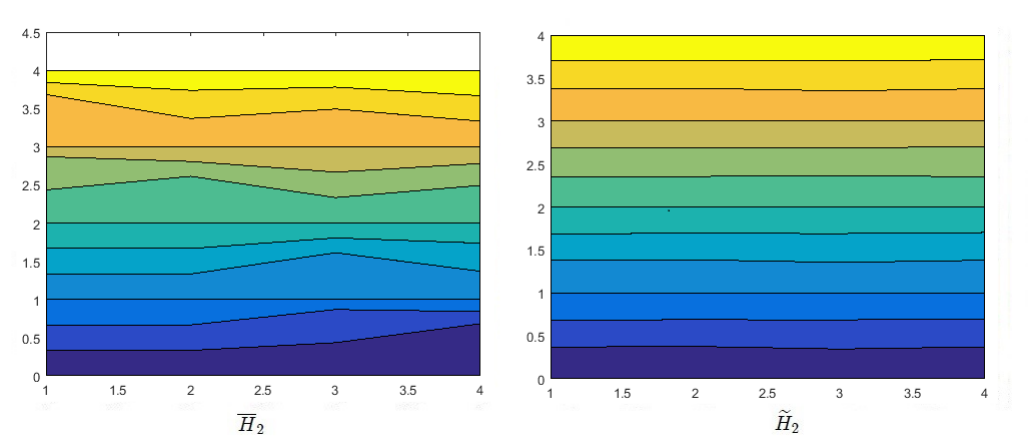
Figure 5. Area graphs of probabilities for H 2 .